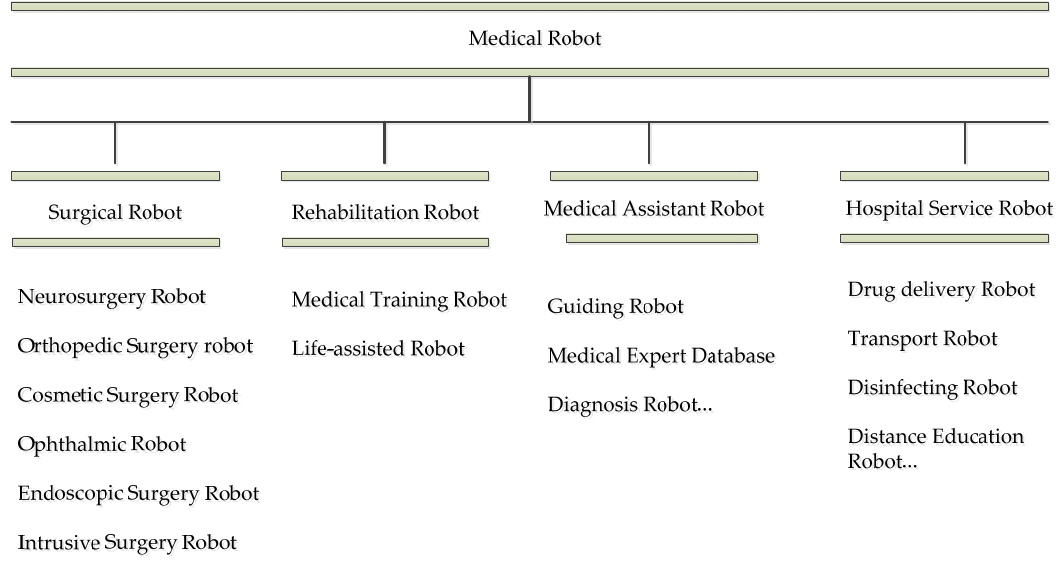
Figure 1. The proposed classification strategy in our paper.